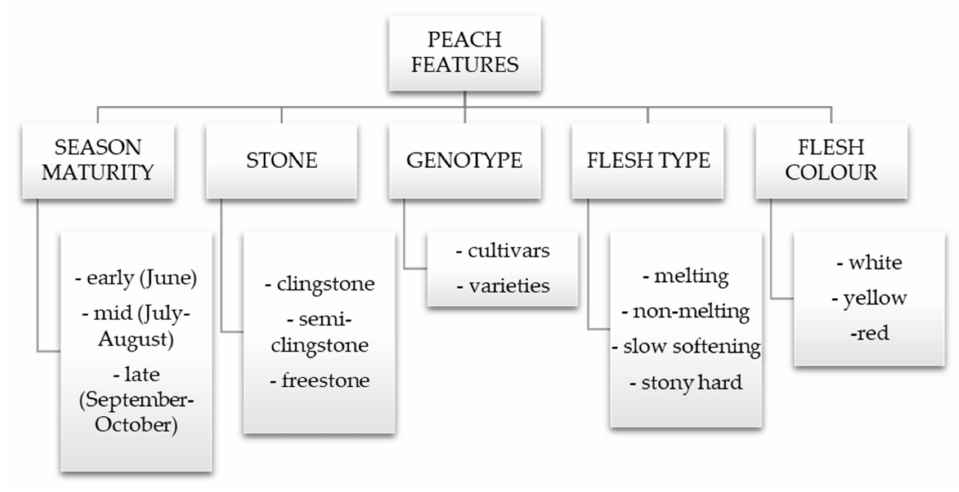
Figure 1. Peach features